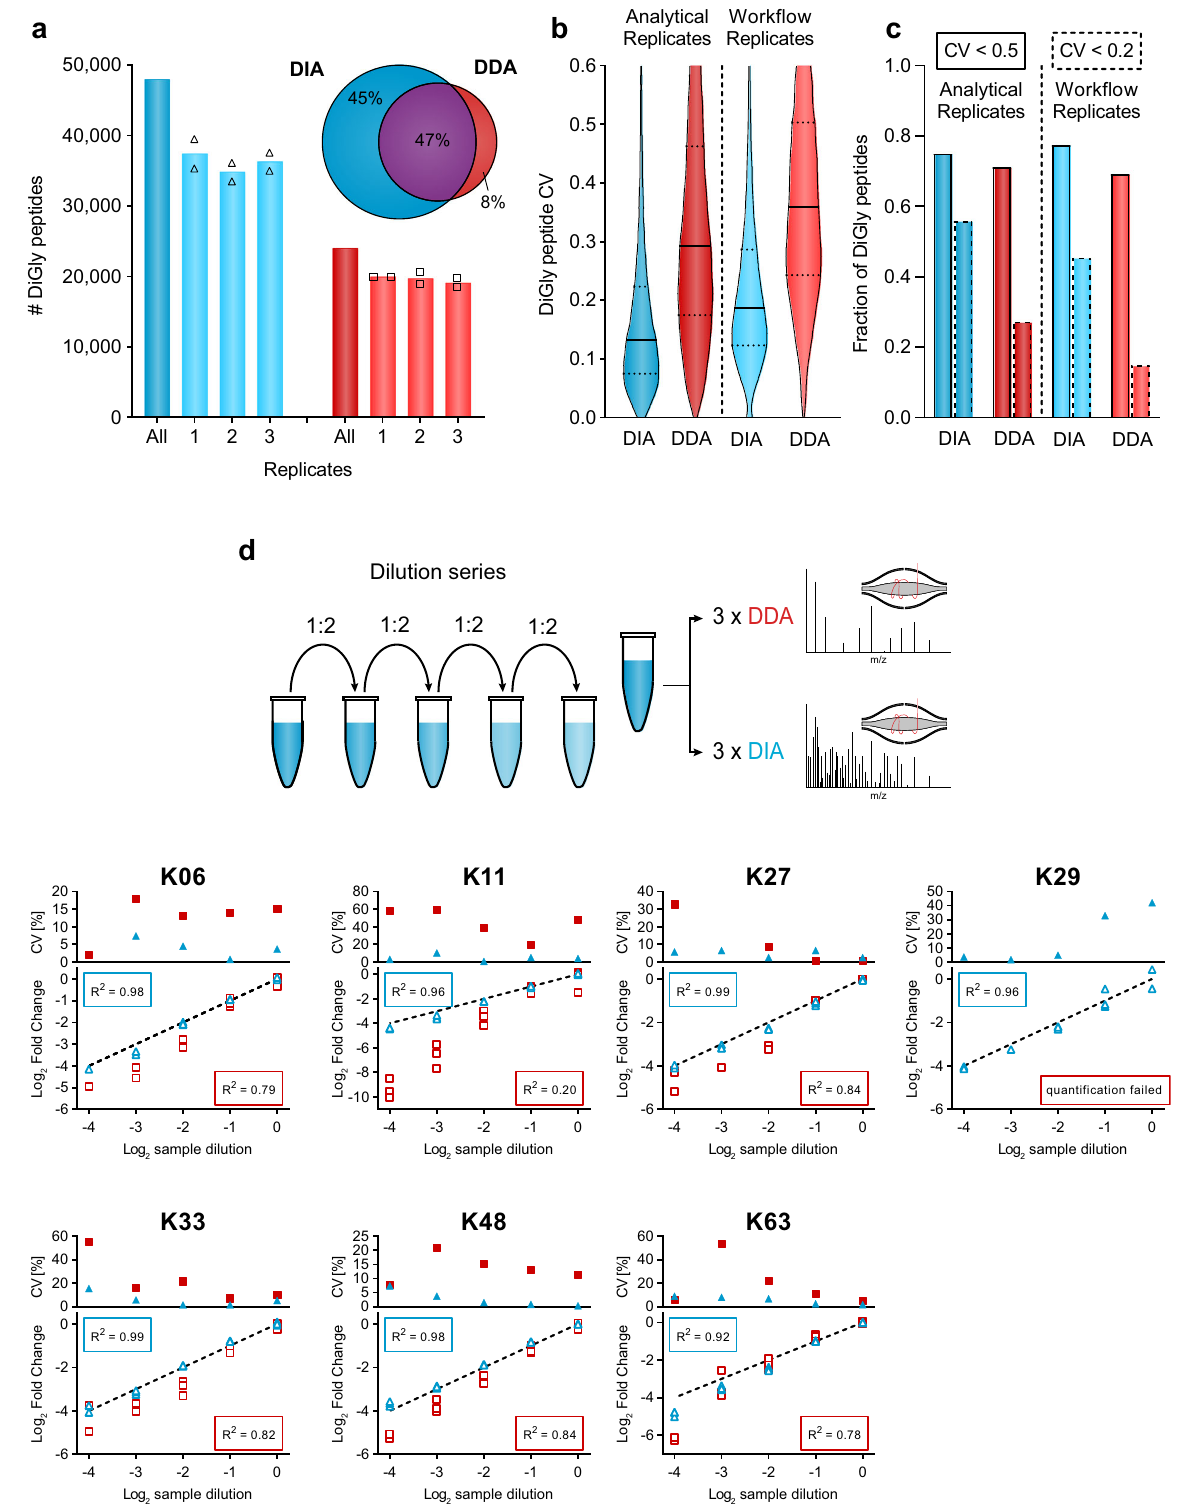
work fl ow, we used MG132 treated HEK293 cells and performed percentage with good CVs (20,000 diGly peptides; 15% with CVs three independent diGly peptide enrichments followed by DIA <20%; Fig. 2a – c). Overall, the six DIA experiments yielded almost analysis in duplicates. This identi fi ed around 36,000 distinct 48,000 distinct diGly peptides, while the corresponding DDA diGly peptides in all replicates, 45% and 77% of which had experiments resulted in 24,000 diGly peptides. Furthermore, the coef fi cients of variations (CVs) below 20% and 50%, respectively improved reproducibility is apparent from the diGly site data (Fig. 2a – c, Supplementary Data 3). In contrast, a DDA method matrix, which has considerably fewer missing values (Supple- identi fi ed substantially fewer distinct diGly peptides and a smaller mentary Fig. 2g). NATURE COMMUNICATIONS| (2021) 12:254